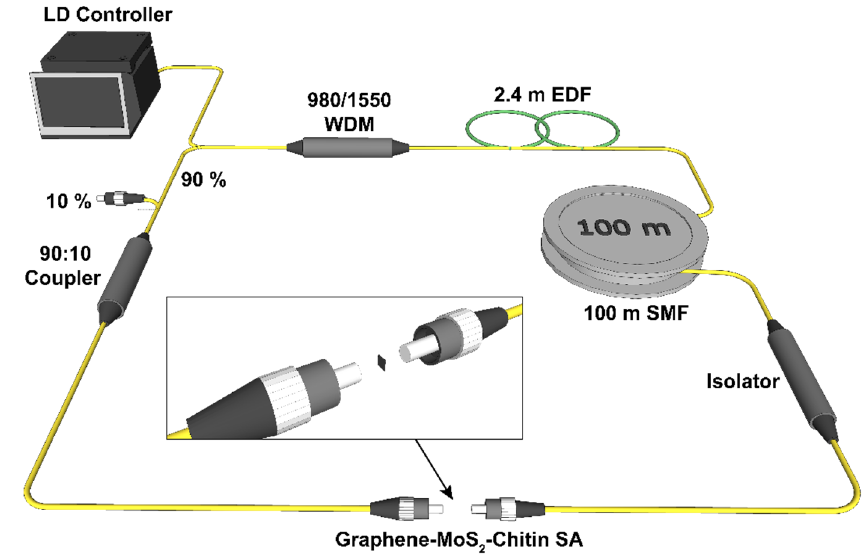
Figure 10. Schematic diagram of fiber laser configuration.